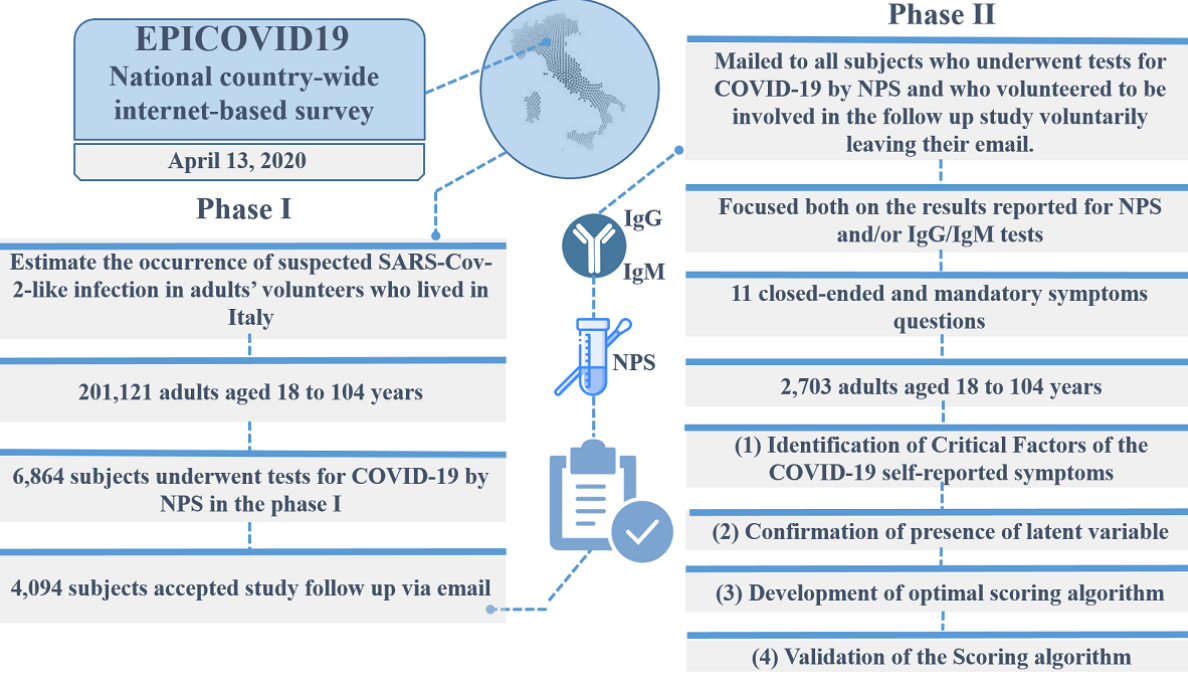
Figure 1. Overview of the EPICOVID19 2-phase study. IgG: immunoglobulin G; IgM: immunoglobulin M; NPS: nasopharyngeal